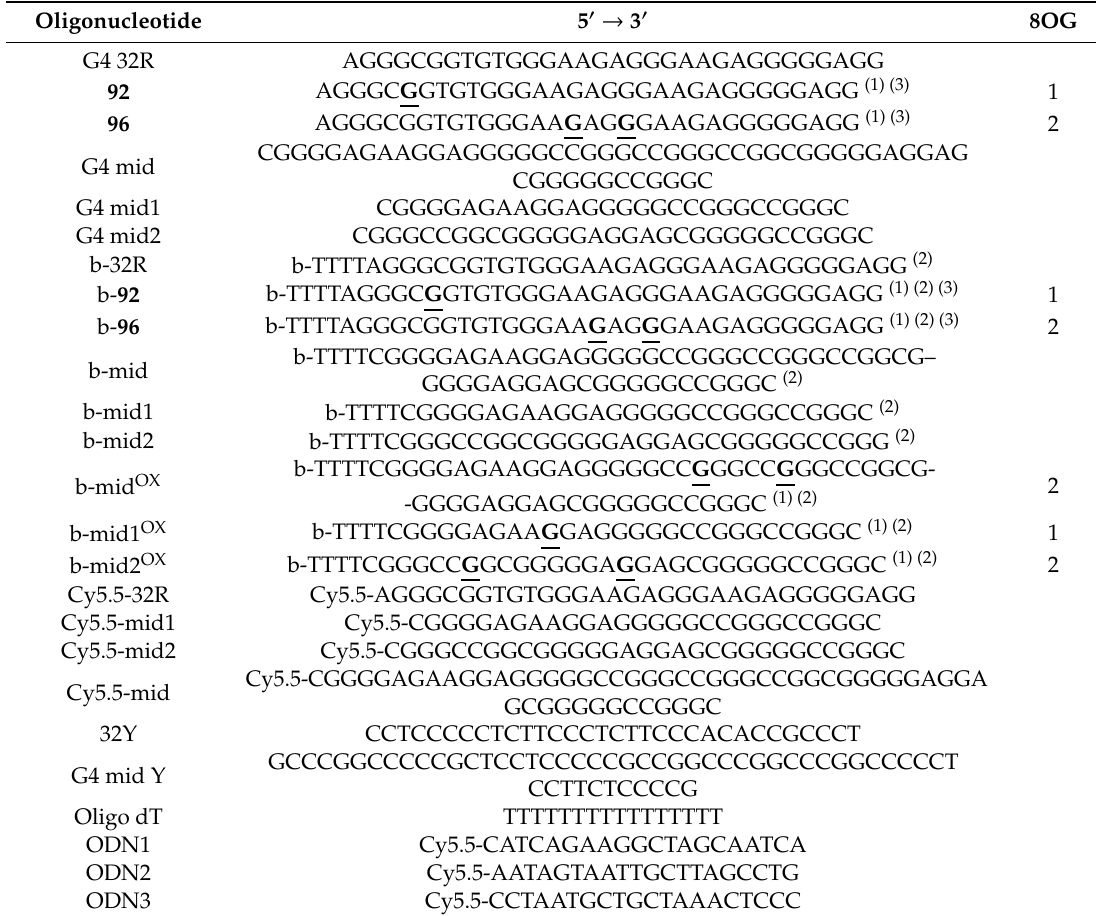
Table 1. DNA sequences used in this